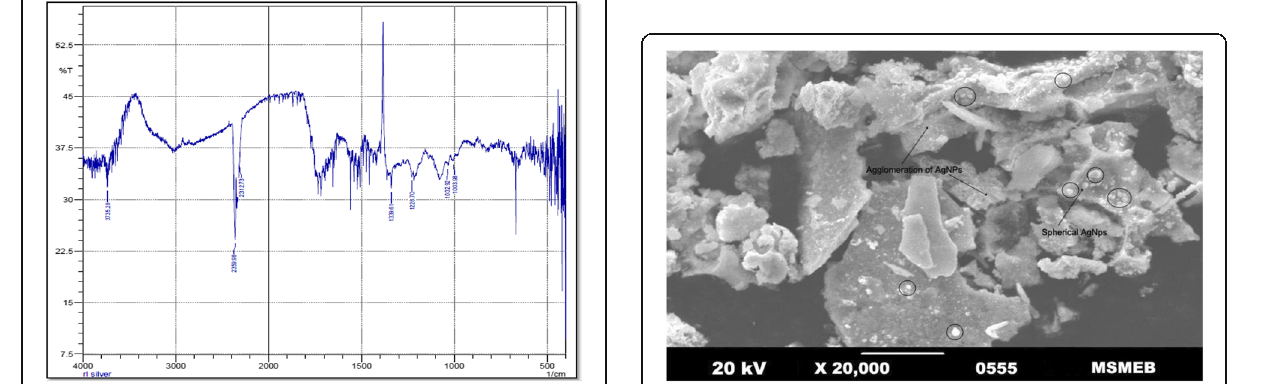
Fig. 3 Infrared analysis of R. laetus -mediated AgNPs